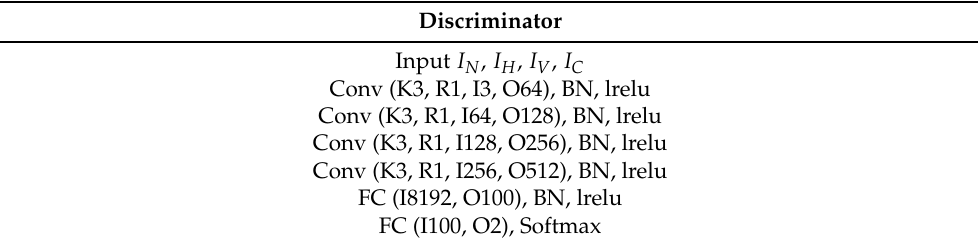
Table 3. Details of the proposed Discriminator, where Conv denotes a convolution operator, K3 is kernel size of 3 × 3, R is dilation rate, I input channel, O output channel, BN Batch normalization, and lrelu is leaky